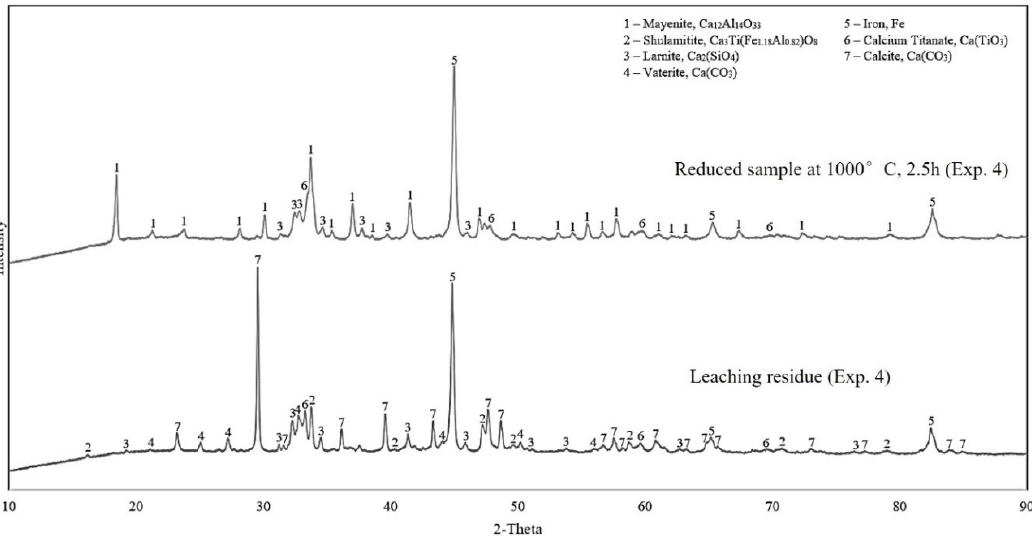
Figure 6. The XRD spectrums of leaching residue of the reduced sample 4 in comparison with the solid before leaching.